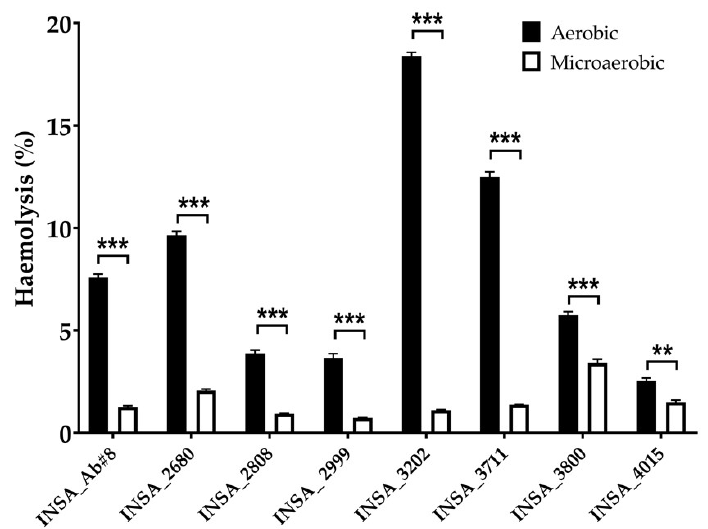
Figure 4. Haemolytic activity of eight clinical isolates of Arcobacter butzleri against human erythro- cytes when in aerobic and microaerobic conditions. Results were analysed using Student’s t -test. The data shown represent the mean ± standard deviation of at least three independent assays. ** p < 0.01, *** p < 0.001.